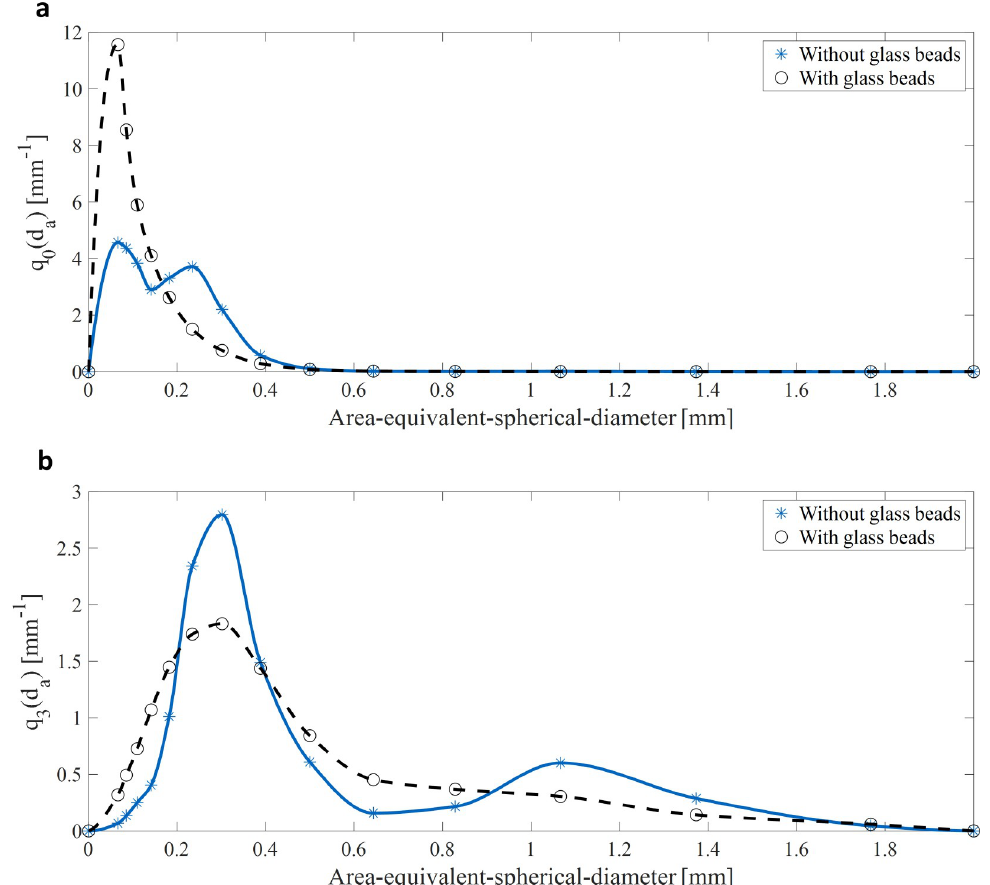
Fig 3. (a) Normalized number-density-distribution q 0 (d a ) and (b) volume-density-distribution q 3 (d a ) of all pellets analyzed through microscopic image analysis during the 10 days of cultivation ( d diameter of the pellet (Eq (2)). Blue star-shaped data points (n = 54.800) represent the cultures processed without glass beads, whereas black circular data points (n = 103.800) show cultures processed with glass